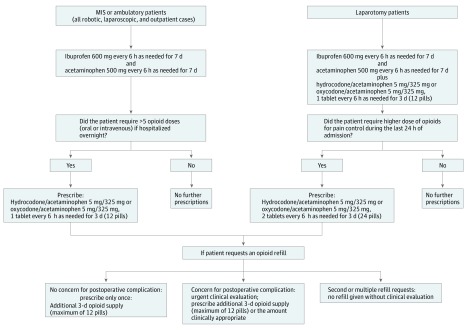
Ultrarestrictive Opioid Prescription ProtocolThe algorithm for prescribing postoperative pain medications at the time of discharge and handling refill requests is shown on the left for minimally invasive surgical (MIS) and ambulatory cases and on the right for laparotomy cases. The protocol remained the same regardless of prior opioid use.